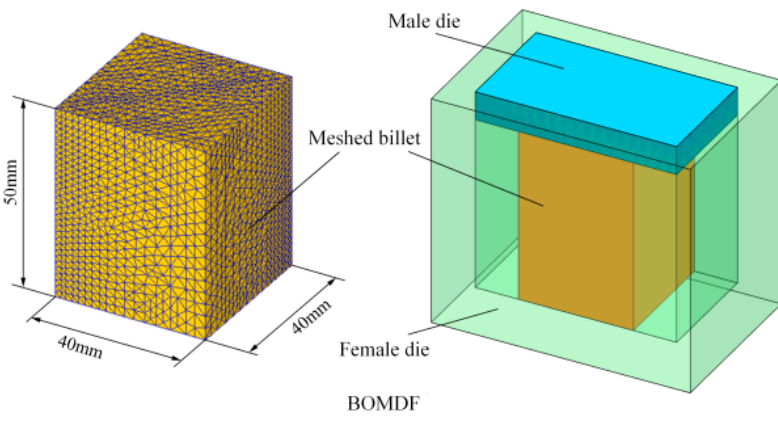
Figure 11. Finite element model.